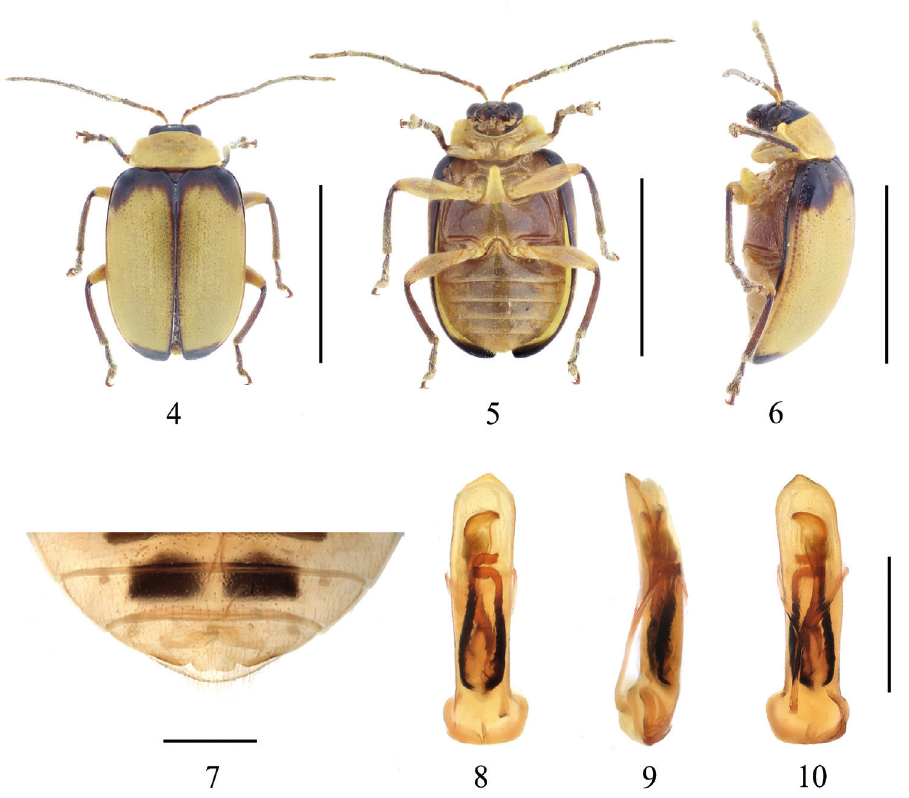
Figures 1–7. Gallerucida fortispina sp. nov. 1 dorsal view (paratype) 2 ventral view (paratype) 3 lateral view (paratype) 4 ventral view of 5 th ventrite, male (holotype) 5 aedeagus, dorsal view (holotype) 6 ditto, lateral view (holotype) 7 ditto, ventral view (holotype). Scale bars: 5 mm ( 1–3 ); 1 mm ( 4–7 Gallerucida levifasciata Xu & Nie, sp. nov. https://zoobank.org/8835C446-57D1-4A27-99F9-6DE40573E9D6